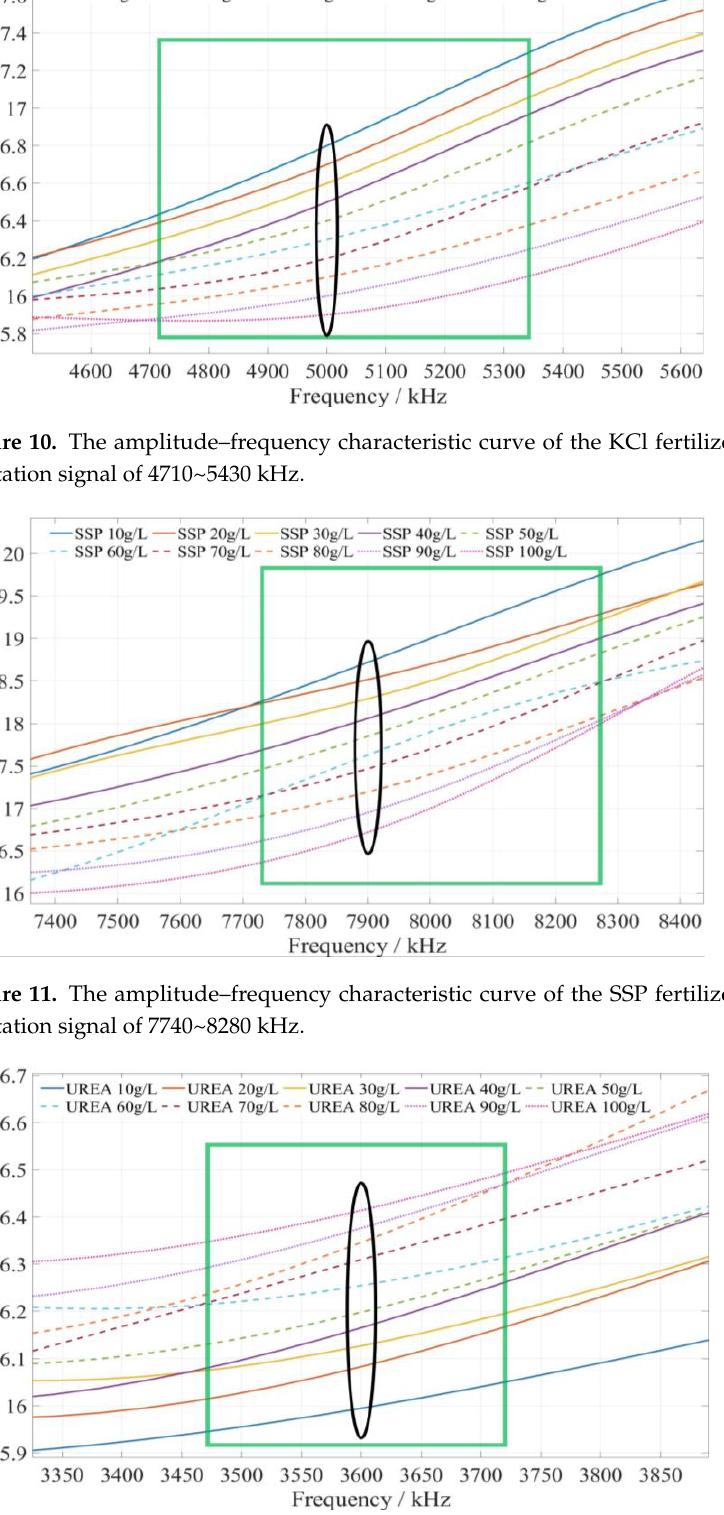
Figure 12. The amplitude – frequency characteristic curve of the urea fertilizer solution under the excitation signal of 3470~3720 kHz.